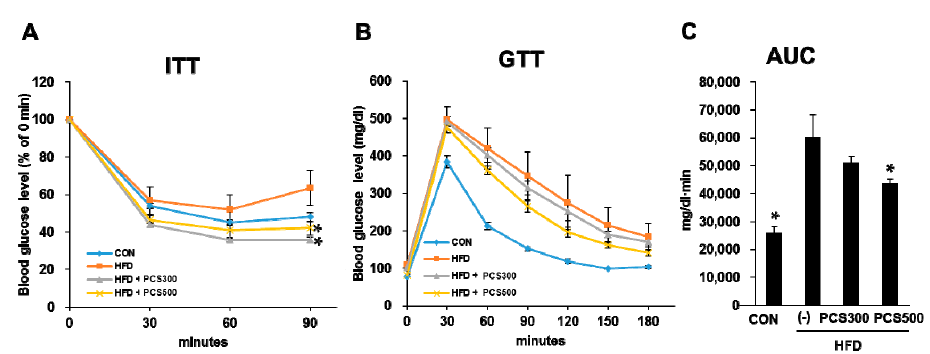
Figure 2. Effect of PCS extract on insulin tolerance and glucose tolerance in HFD-fed mice. Mice were fed with regular chow diet (CON) or HFD for 12 weeks. HFD-fed were treated with vehicle or PCS extract (300 or 500 mg/kg/day) from the first day of HFD feeding ( n = 7–10/group). ( A ) Insulin tolerance tests (ITT) were performed after 12 weeks of PCS treatment. Blood glucose levels were measured at the indicated times after insulin injection (1 U/kg Intraperitoneal (i.p.)); ( B ) Glucose tolerance tests (GTT). Blood glucose levels were measured at the indicated times after glucose load (2 g/kg i.p.); ( C ) Area under the curve (AUC) of GTT graph. * p < 0.05 vs. vehicle-treated HFD-fed mice.